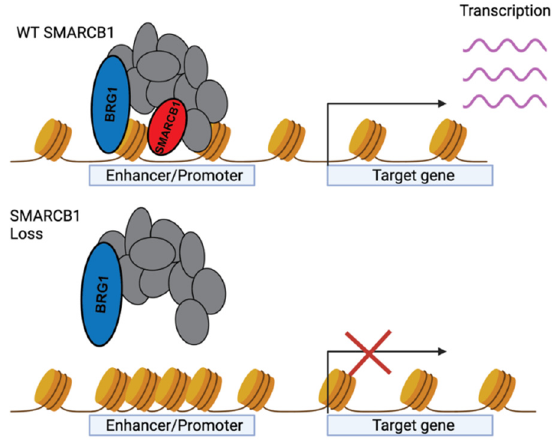
Figure 3 . Role of SMARCB1 within the BAF complex in regulating gene